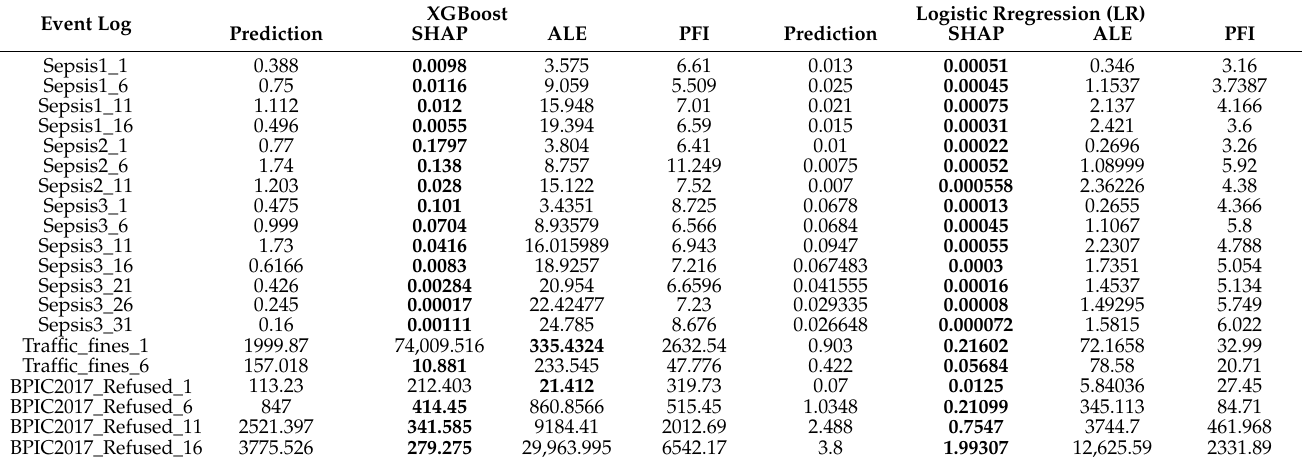
Table 4. Execution times (in seconds) of XAI methods on event logs preprocessed using prefix index